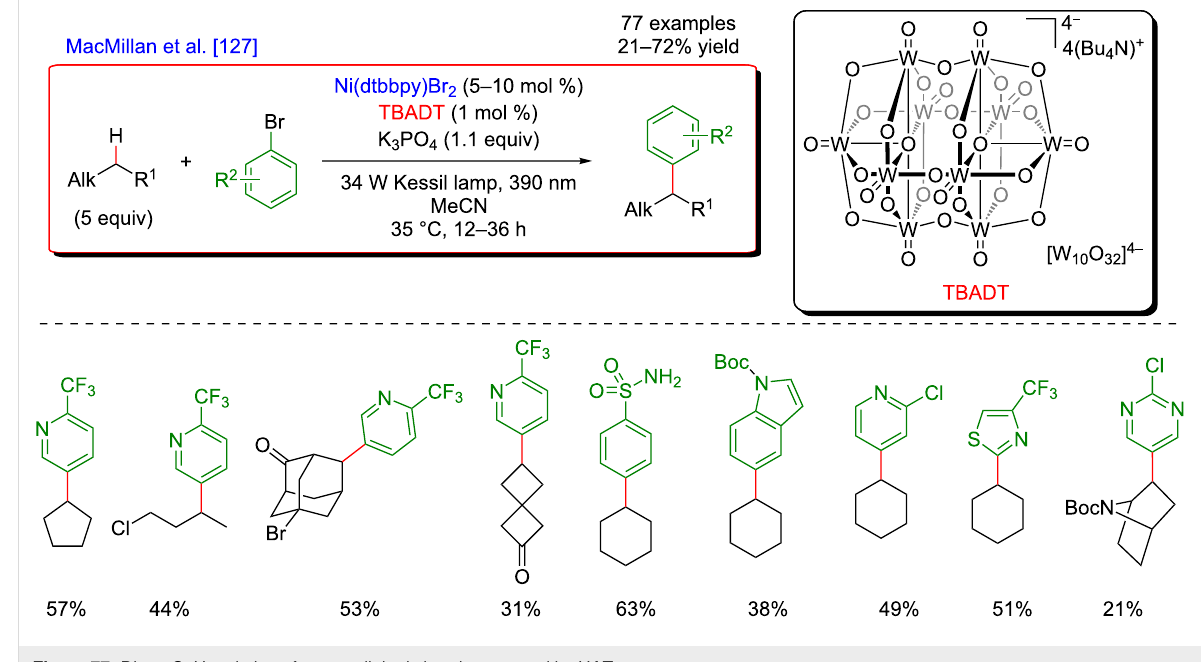
Figure 77: Direct C–H arylation of strong aliphatic bonds promoted by HAT.